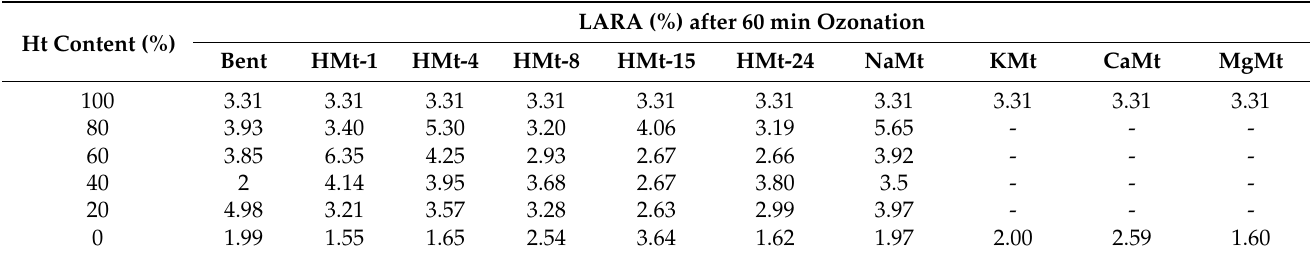
Figure 8. LA depletion in time during ozonation in the presence of 80–20% Ht-Mt mixture as determined by HPLC-UV. Since montmorillonite (Mt) is the preponderant clay mineral with expanded structure in bentonite and modified counterparts, the latter was denoted in this figure as Mt. Table 2. Comparison of the LA residual amount for ozonation with clay minerals and their mixtures.